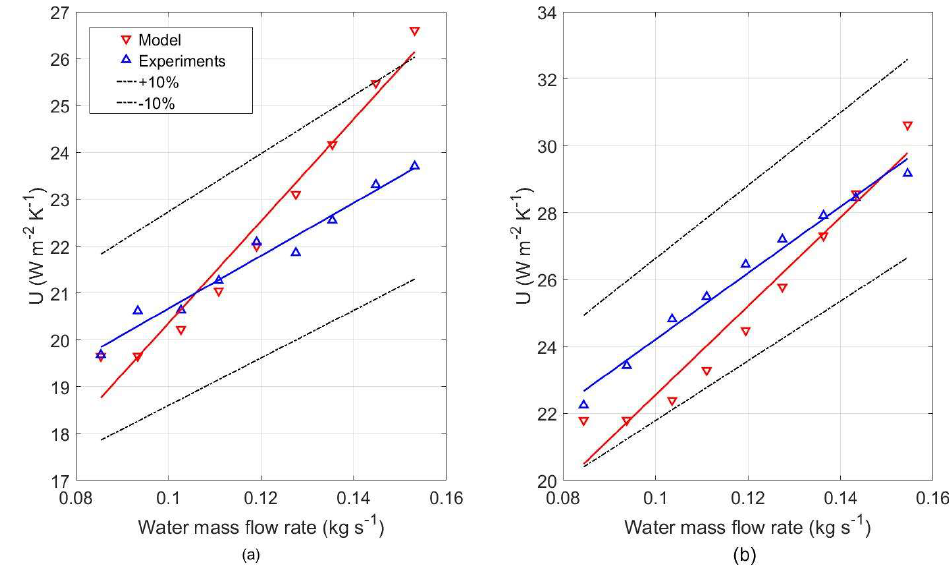
Figure 4. Deviations between the model and experimental overall heat transfer coefficient for 45 °C water inlet temperature at ( a ) 50 Hz; and ( b ) 80 Hz fan frequency.